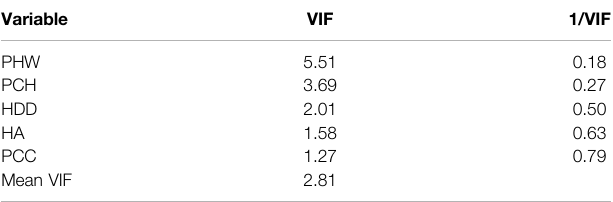
TABLE 3 | The results of multicollinearity test.